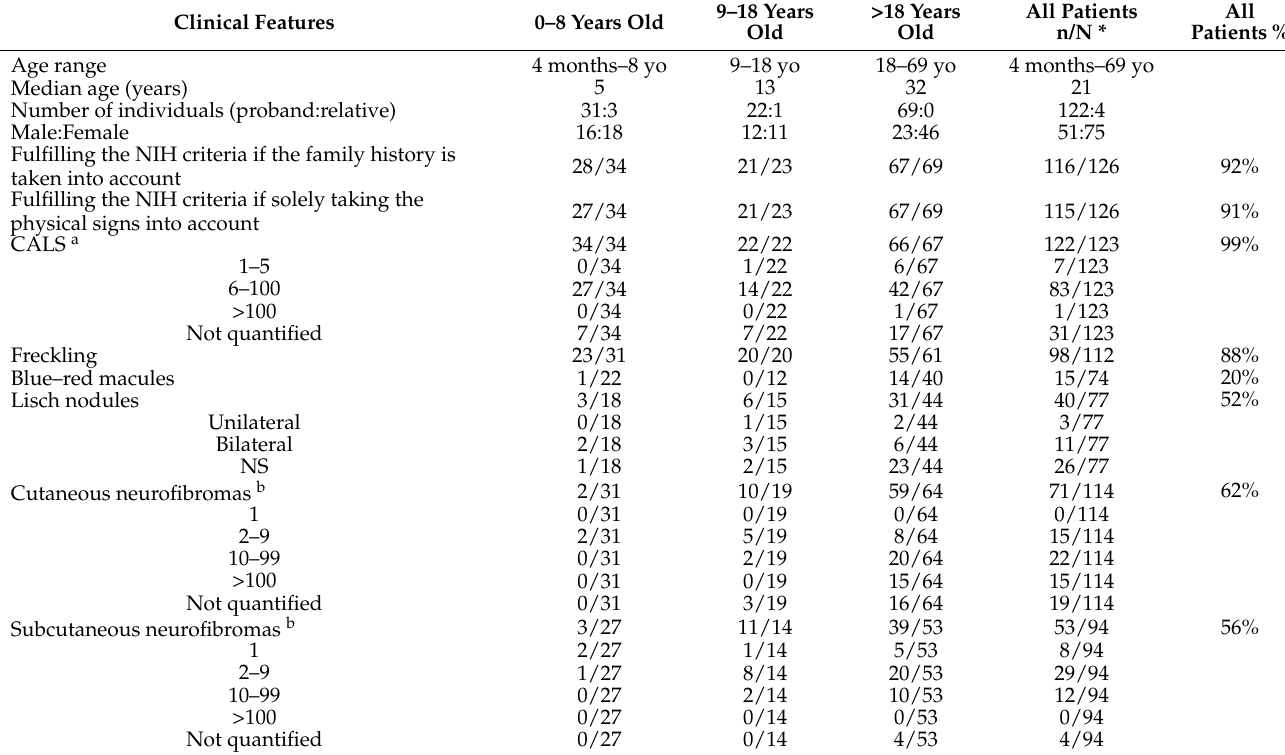
Table 1. Clinical findings in the NF1 -deleted